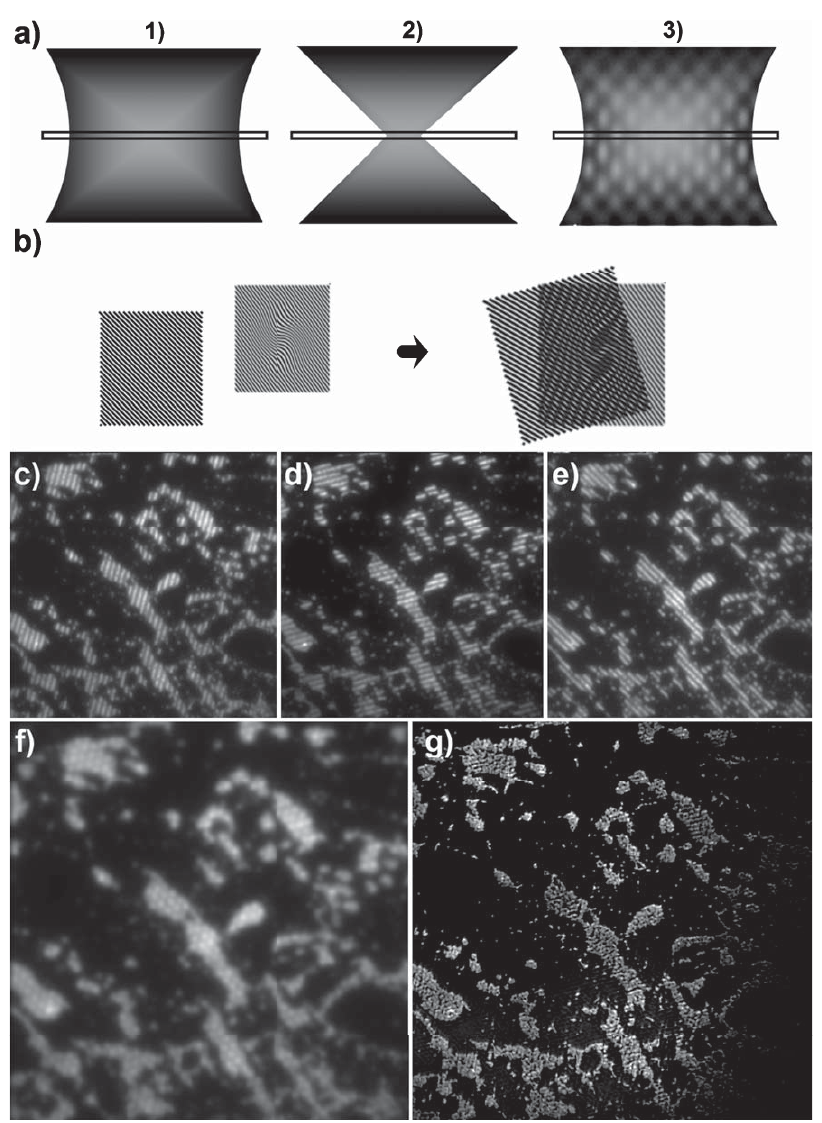
Fig. 1. (a) Different illumination profiles near the sample plane in (1) wide field; (2) confocal and (3) structured illumination configurations. (b) A moire pattern generated from a high spatial frequency feature of the sample with a structured illumination pattern. (c, d, and e) Structured illumination patterns generated by interference laser beams at the sample plane at three different orientations. (f and g) An ordinary wide field illumination image and a reconstructed structured illumination image of the same